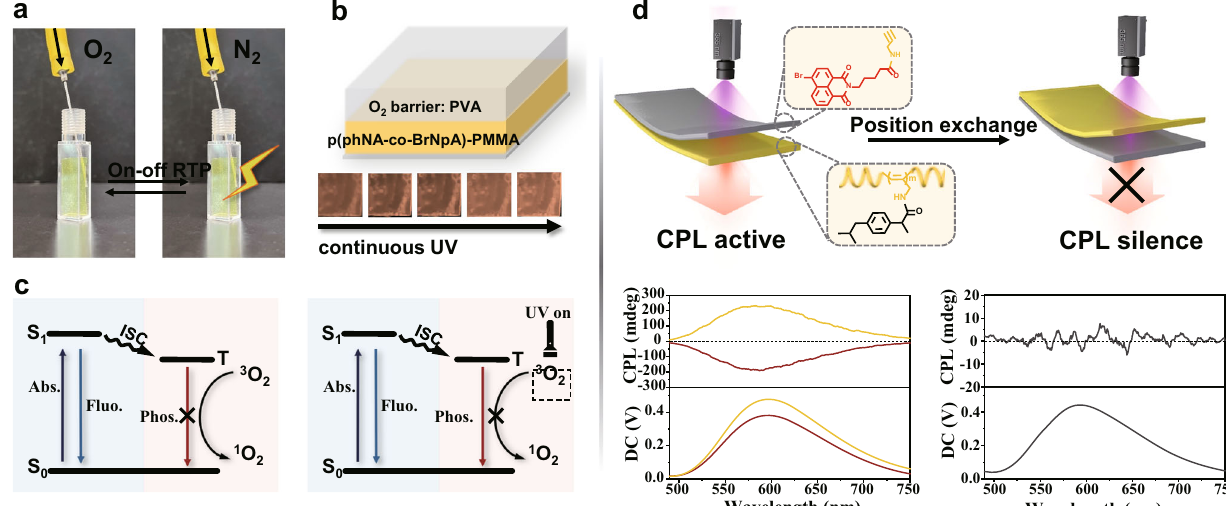
Fig. 4 | The mechanism of photoinduced circularly polarized RTP. a Nitrogen and oxygen were alternately fi lled into the quartz tube. p( R- phNA 7 BrNpA 3 )-PMMA exhibited RTP “ turn-on ” and “ off ” under 365nm UV irradiation. b Schematic dia- gram and photograph of p(phNA-co-BrNpA)-PMMA coated with a layer of PVA.